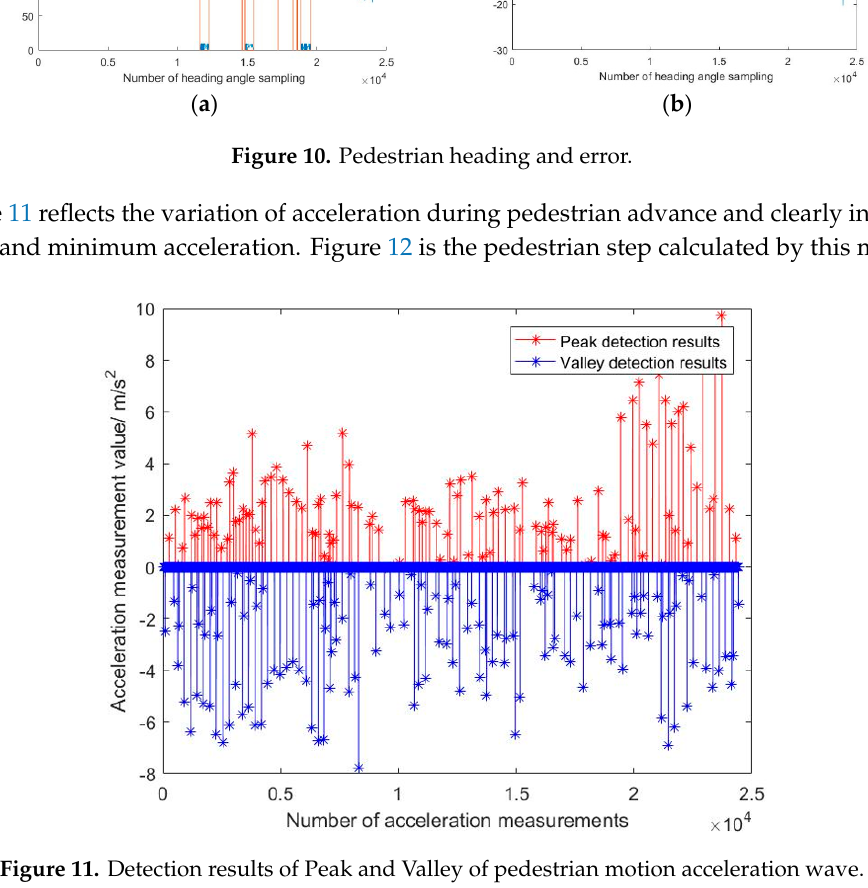
Figure 11. Detection results of Peak and Valley of pedestrian motion acceleration wave.